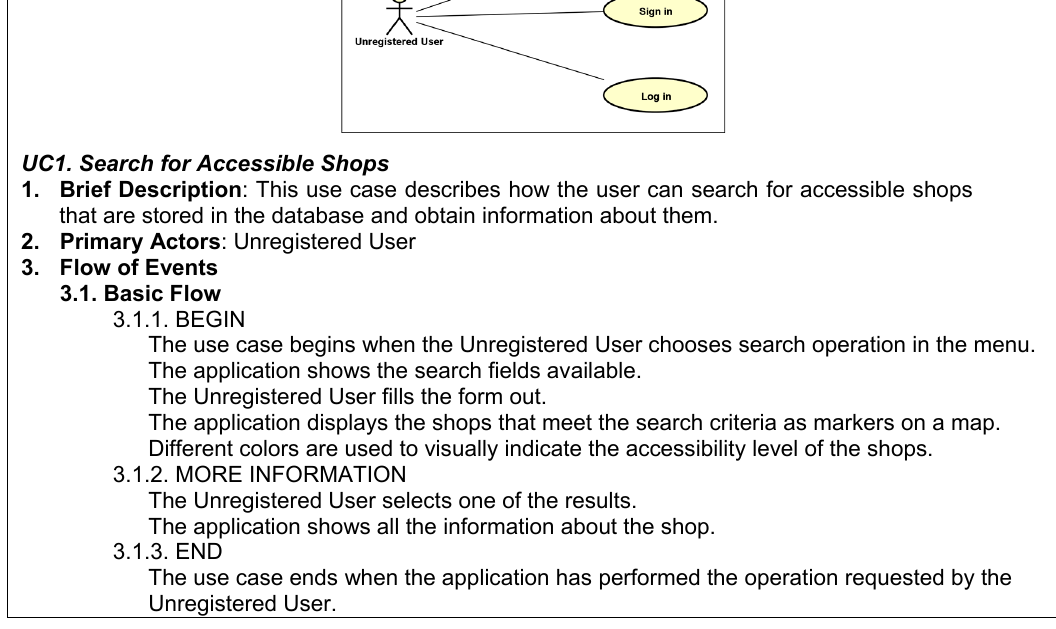
Figure 3. Use case diagram for the unregistered user.